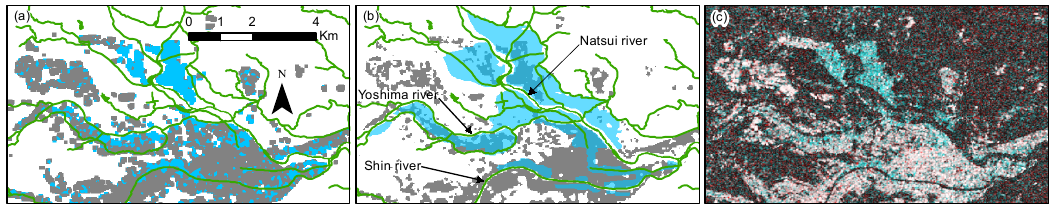
Figure 7. Closer look of the affected area in the city of Iwaki, Fukushima Prefecture. ( a ) The predicted flood map. ( b ) The reference flood map provided by the Iwaki city. ( c ) The RGB coherence color composite. Their locations are indicated in Figure 5a.